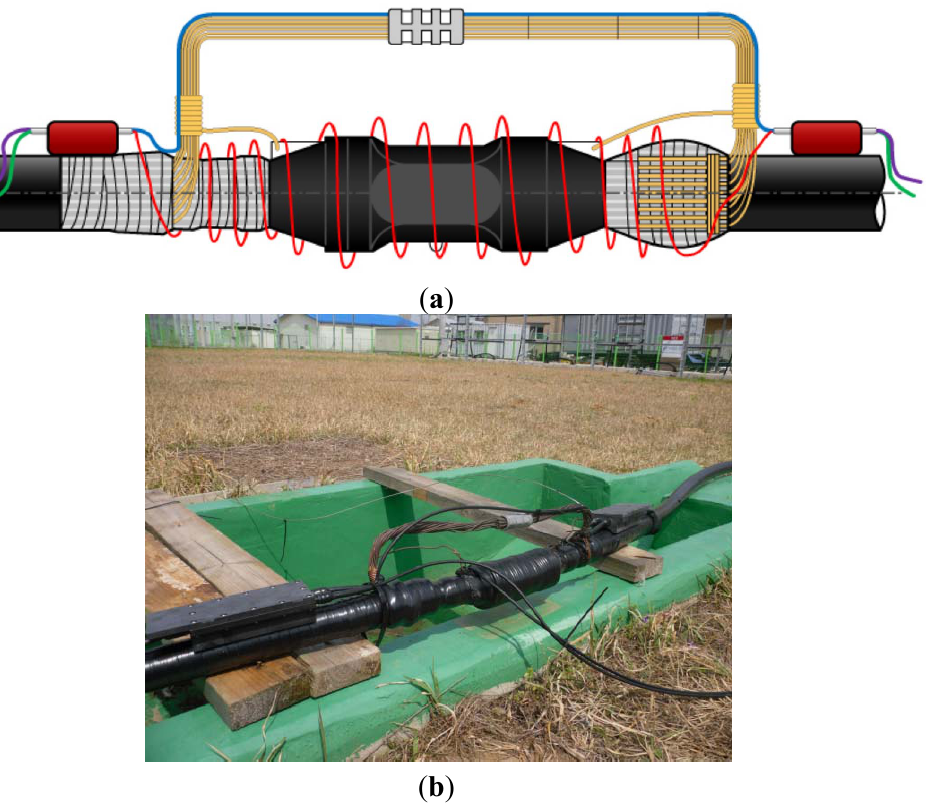
Figure 4. OFCPC: ( a ) structure and ( b ) installation of a cable